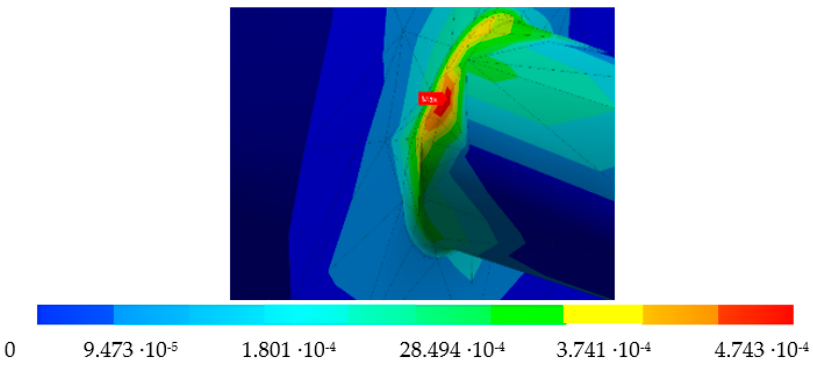
Figure 6. Maximum shear stress, Aluminum 7075-O material.